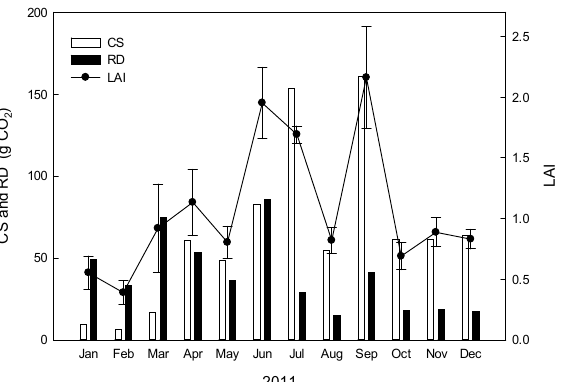
Figure 4. Monthly daytime CO 2 assimilation (CS), night respiration (RD), and leaf area index (LAI) of Zelkova serrata (Thunb.) Makino. N = 3, bars indicate ± standard error.